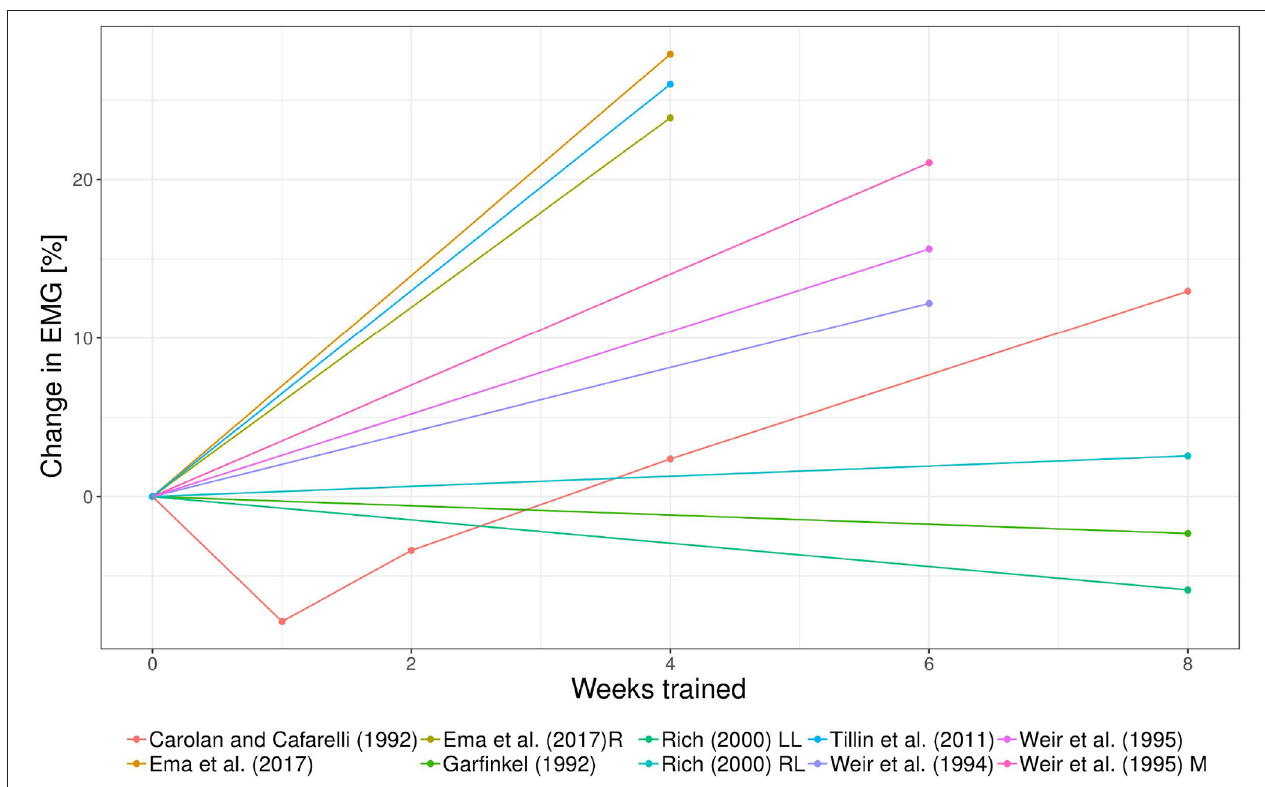
FIGURE 2 | Spaghetti plot of the data on EMG over time in weeks obtained from Carolan and Cafarelli (1992), Garfinkel and Cafarelli (1992), Weir et al. (1994, 1995), Rich and Cafarelli (2000), Tillin et al. (2011), and Ema et al. (2017). Here R, rectus femoris; LL, left limb; RL, right limb; and M, vastus medialis. Where not specified, data were obtained from vastus lateralis